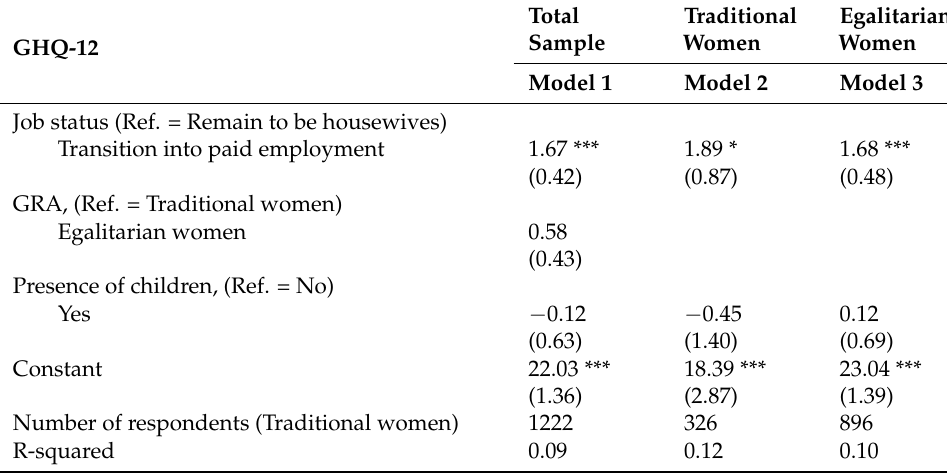
Table 2. Ordinary least squares (OLS) regressions predicting the impact of transitioning from being a housewife to paid employment on women’s mental health. GHQ-12